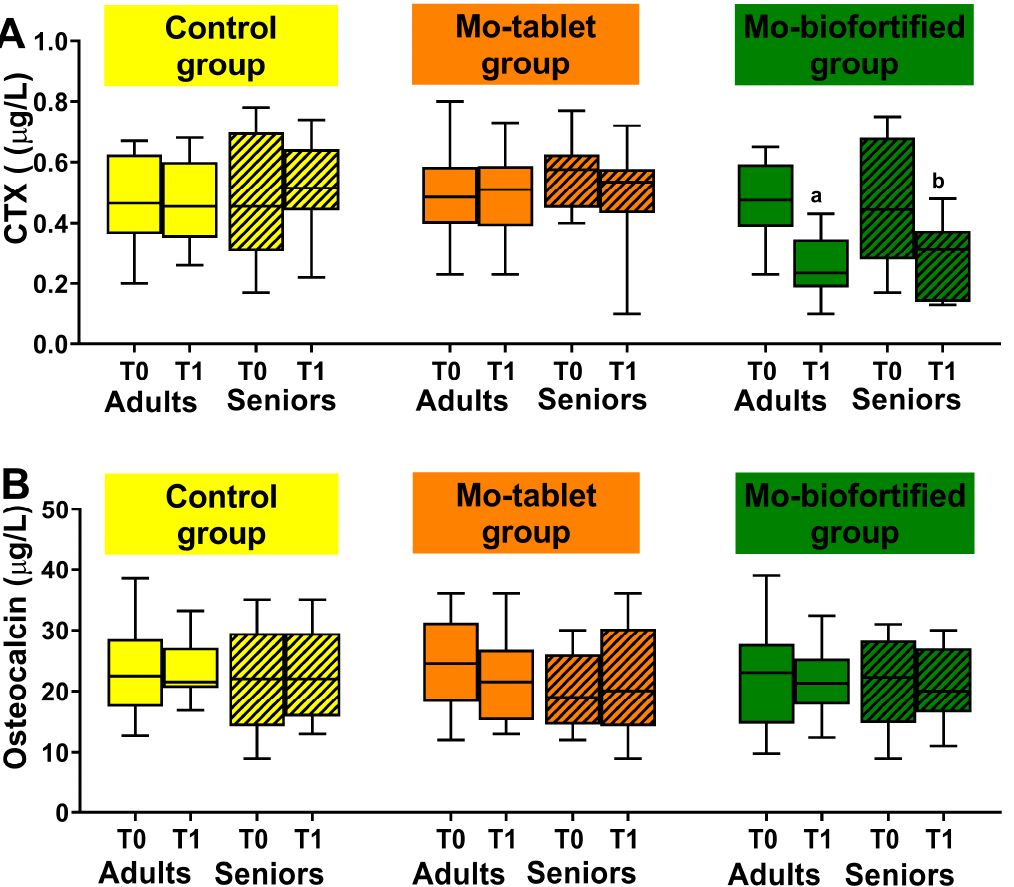
Figure 3. Bone remodeling markers were measured at baseline and after 12 days in the three groups: the control group (supplemented once a day with 100 g a day of lettuce), the Mo-tablet group (supplemented once a day with molybdenum in tablet form) and the Mo-biofortified group (supplemented with 100 g a day of molybdenum-biofortified lettuce). ( A ) Box plot showing serum concentration of the marker of bone resorption, CTX, in control, Mo-tablet and Mo-biofortified groups. ( B ) Box plot showing serum concentration of the marker of bone formation, osteocalcin, in control, Mo-tablet and Mo-biofortified groups. The letter a denotes a significant difference ( p < 0.05) of Mo-biofortified lettuce compared with the control (T0 and T1), Mo tablet (T0 and T1) and T0 of Mo-biofortified lettuce in the adult group. The letter b denotes a significant difference ( p < 0.05) of Mo-biofortified lettuce compared with the control (T0 and T1), Mo tablet (T0 and T1) and T0 of Mo-biofortified lettuce in the senior